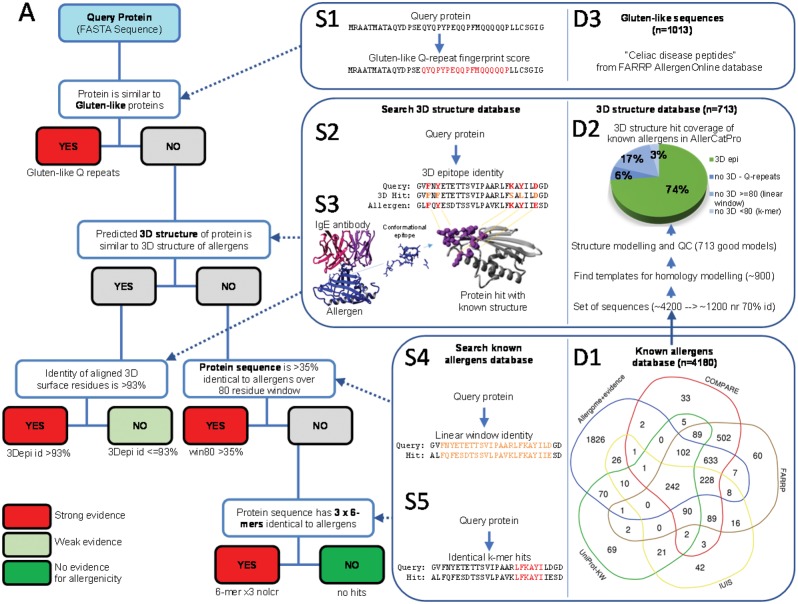
AllerCatPro workflow, search methods and databases. (A) Decision workflow of AllerCatPro from the query protein to the results of either strong, weak or no evidence for allergenic potential. (S1–S5) Search methods utilized at different stages of the workflow. (D1–D3) Databases created and used for the searches in the workflow